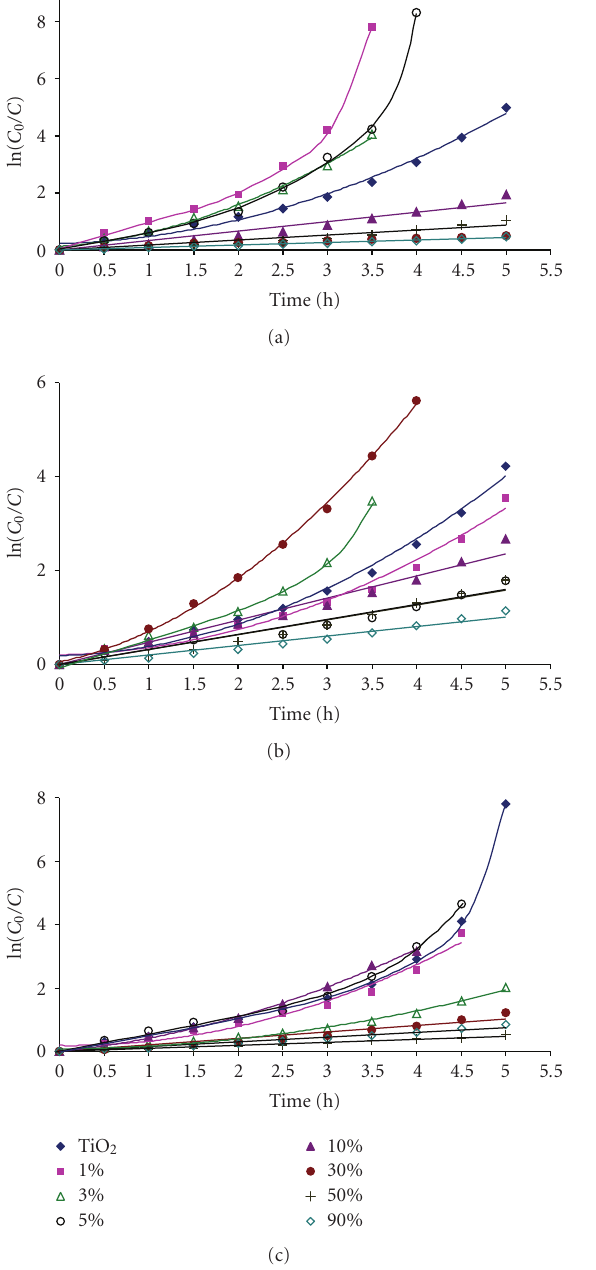
Figure 6: AR decomposition under UV irradiation on TiO 2 and TiO 2 -WO 3 photocatalysts, (a) as received, (b) 400 ◦ C-treated, and (c) 600 ◦ C-treated.